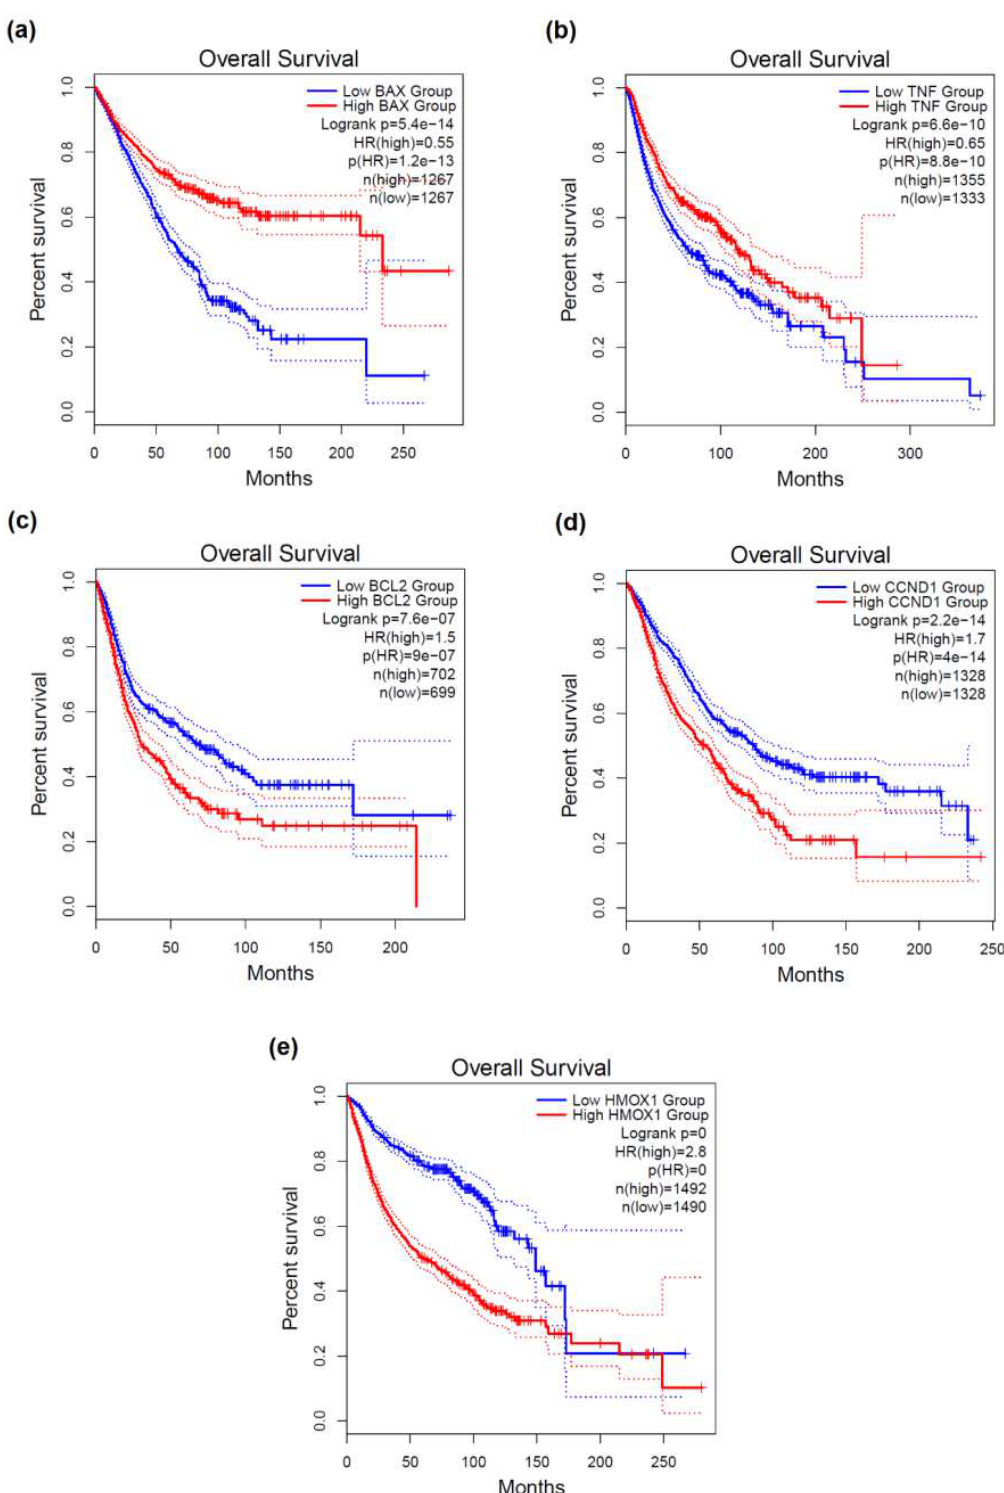
Figure 3. Kaplan–Meier curves representing the prognostic potential of selected pivotal genes ( a ) BAX , ( b ) TNF , ( c ) BCL2 , ( d ) CCND1 , and ( e ) HMOX1 for overall survival in diverse cancers. The HR “HR(high)” and the corresponding p -values “p(HR)” are shown. The 95% confidence intervals (CI) are indicated by dotted lines. The number of high-risk and low-risk patient groups are denoted by “n(high)” and “n(low),” respectively. An HR value above 1 indicates an increased mortality risk, whereas an HR below 1 denotes a lower risk. Cancer patients with elevated expression of BCL2 , CCND1 and HMOX1 may die at a higher rate per unit time of those where the genes BAX and TNF are overexpressed.